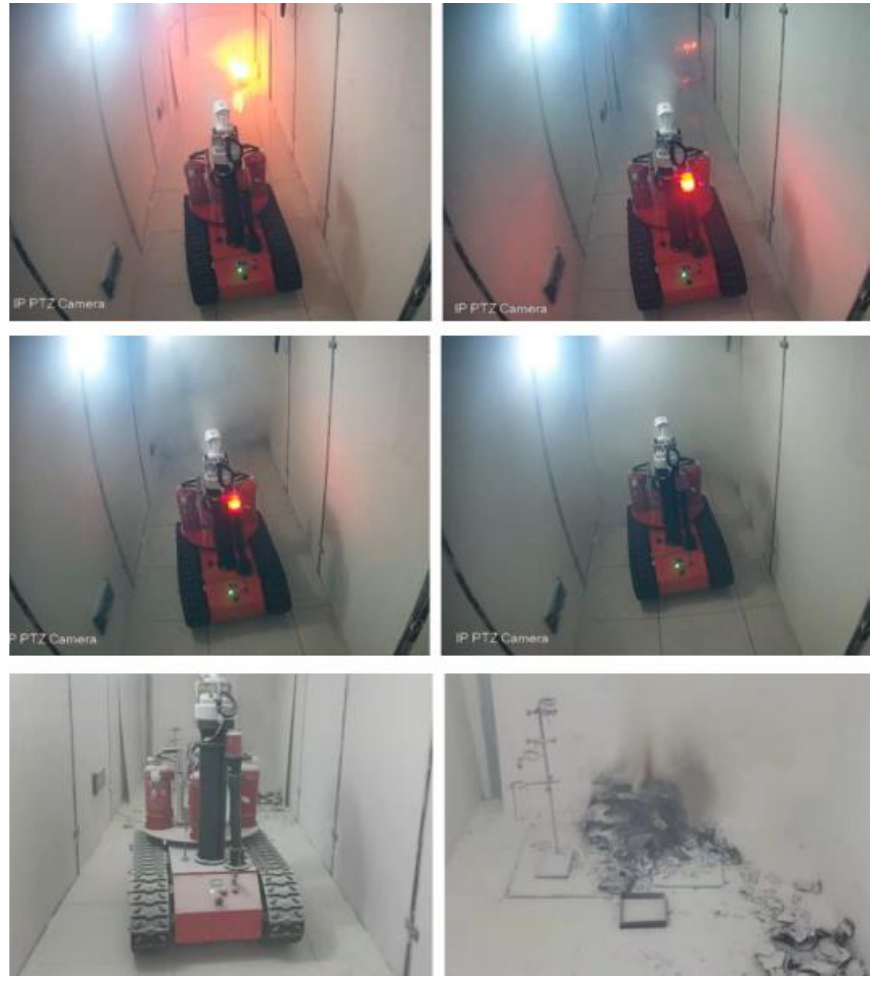
Figure 25. The robot finds flames and extinguishes them during the autonomous